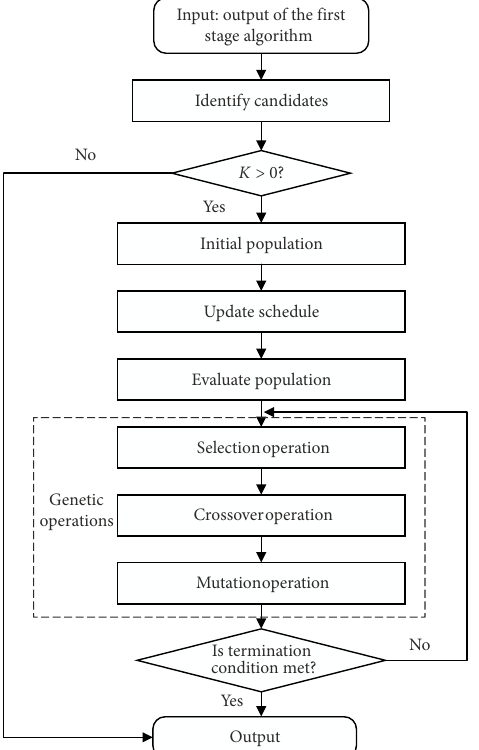
Figure 7. The first stage algorithm Figure 8. The second stage algorithm